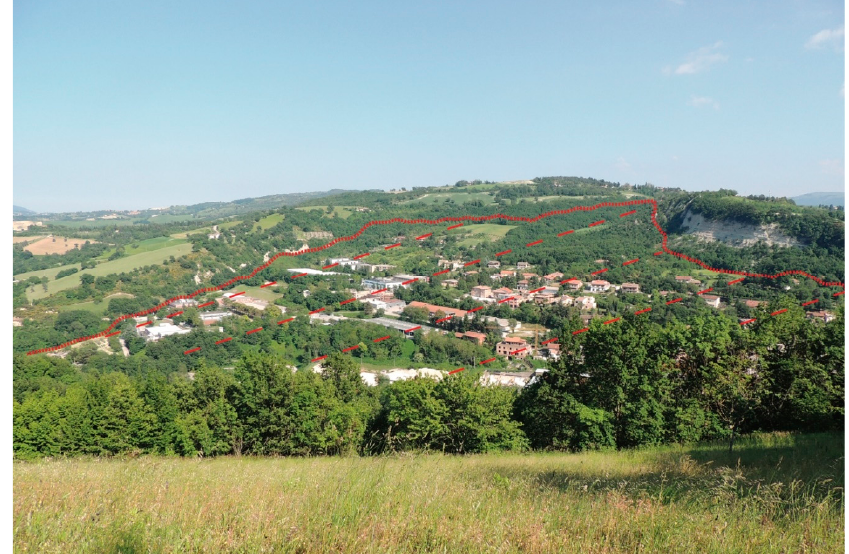
Figure 8. Panoramic view from west of the Sasso urbanized area (ID anomaly n° 5), near the Urbino city. Marked in red dashed lines is a landslide body that represent a collapse of a wider rock slope deformation (i.e., deep ‐ seated gravitational slope deformation). At the landslide toe, not visible in the picture, the Apsa River is characterized by a knickzone at a stream reach where an epigenetic valley